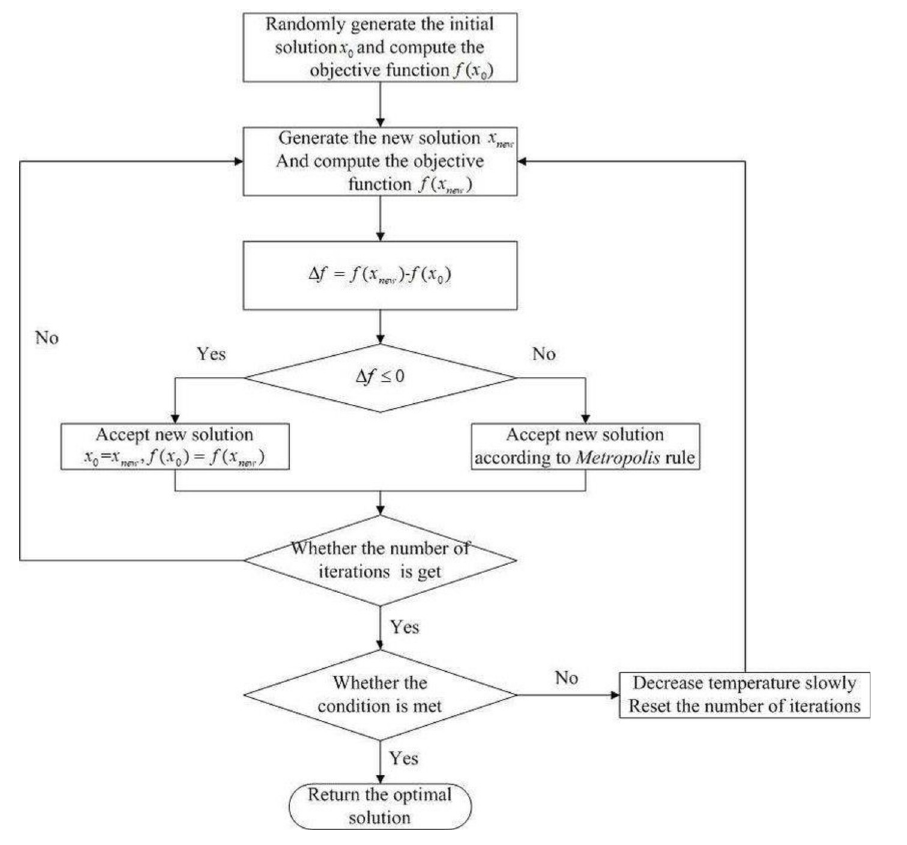
Fig 9. Simulated annealing algorithm